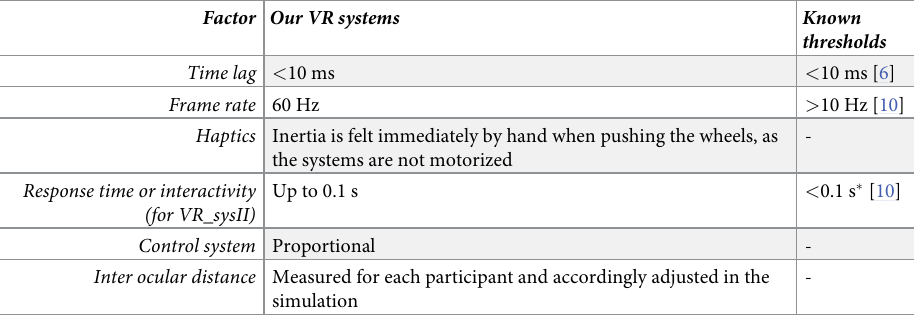
Table 1. Technical descriptions of the VR systems.